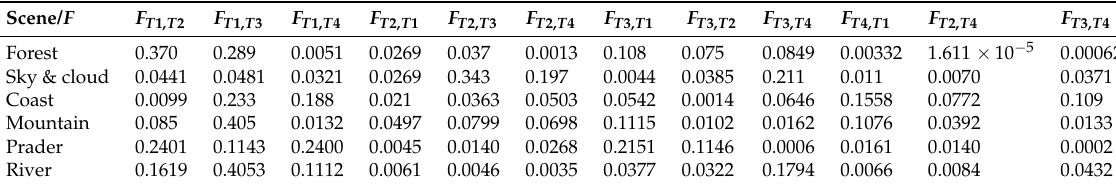
Table 2. The obtained τ matrix values.